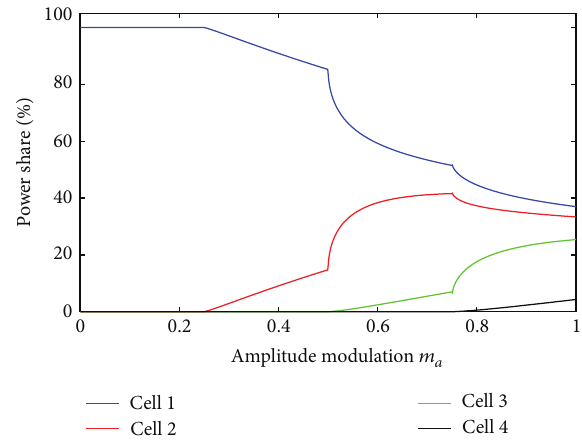
Figure 8: Relative power distribution between the four cells for different 𝑚 𝑎 , using the PD control